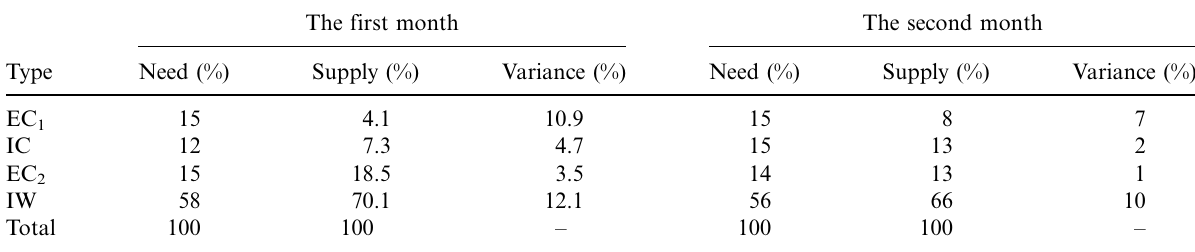
Table 6. Coordination needs and supply of the case